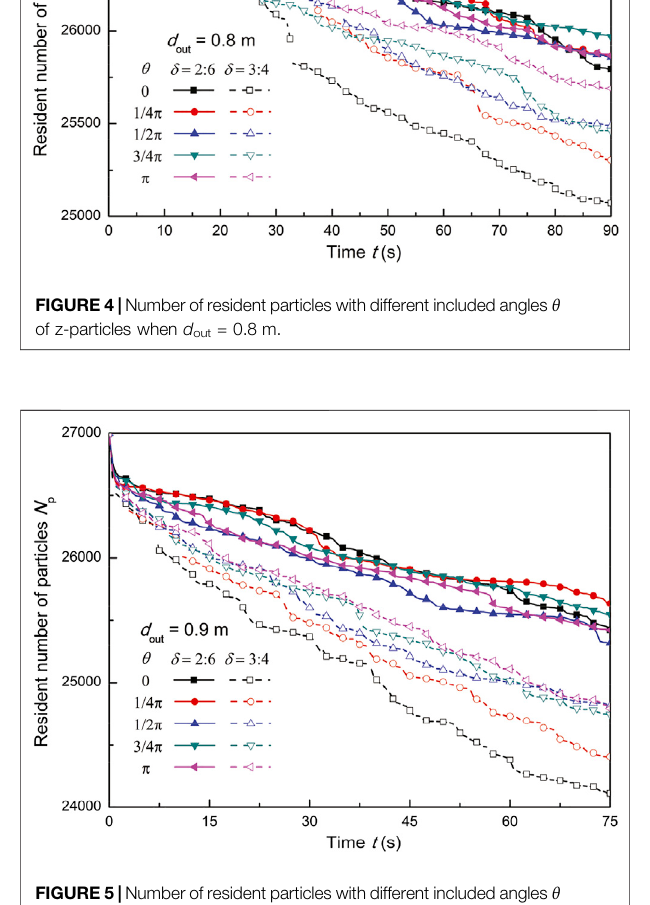
FIGURE7 | Number ofresident particleswith different included angles β of u-particles when d out (cid:1) 0.9